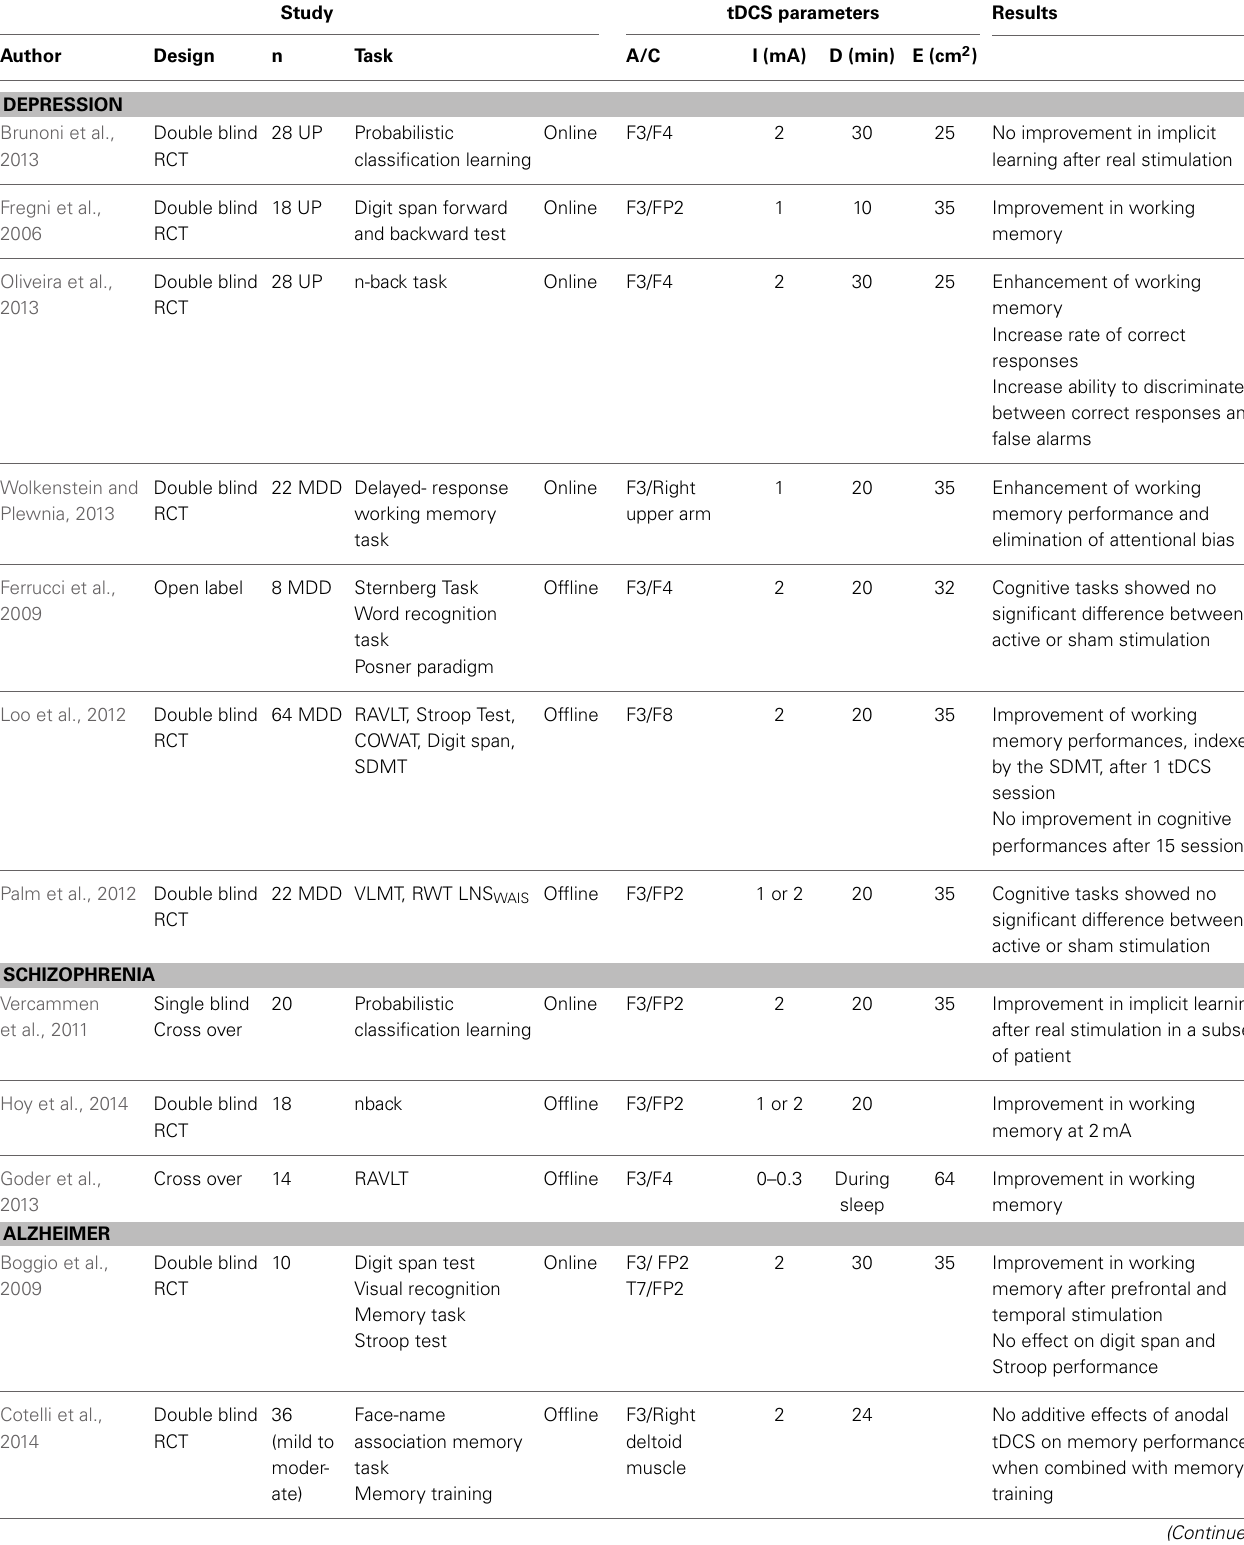
Table 1B | Studies investigating the cognitive effects of tDCS in psychiatric